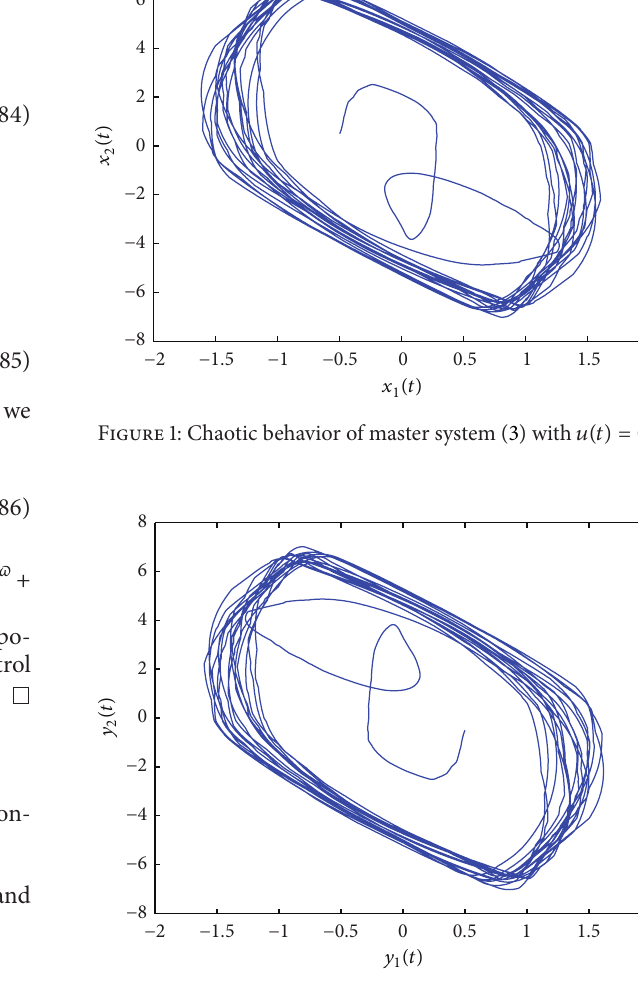
Figure 2: Chaotic behavior of slave system (6) with 𝑢(𝑡) = 0